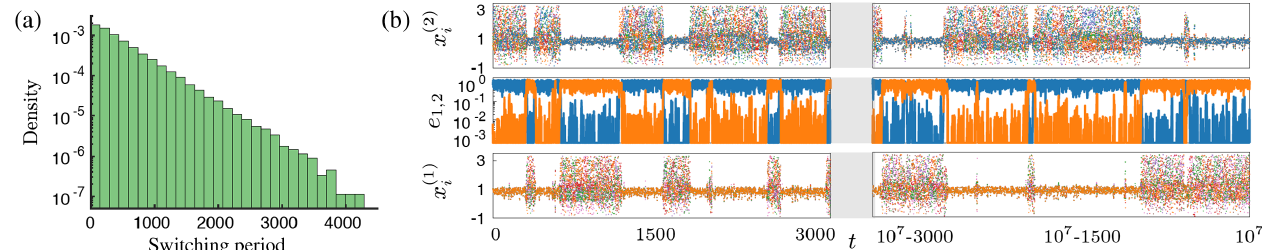
FIG. 9. Statistics and dynamics of a switching chimera in the experiments. (a) Distribution of switching periods for β ¼ 1 . 3 and σ ¼ 1 . 05 [green dot in Fig. 8(b)]. (b) Portion of the experimentally measured time series used to generate (a). These measurements are performed at the base-noise level of the system, which is estimated to be